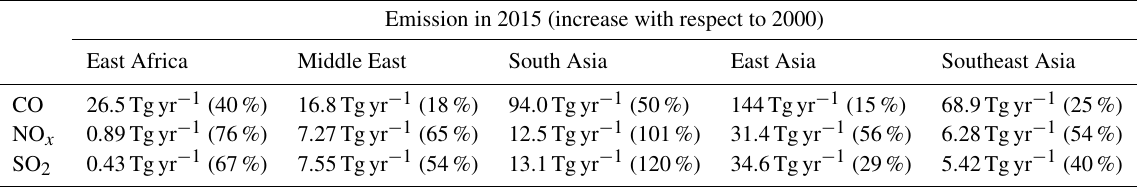
Table 2. Emissions of CO, NO x , and SO 2 from different regions in 2015 and their increase with respect to